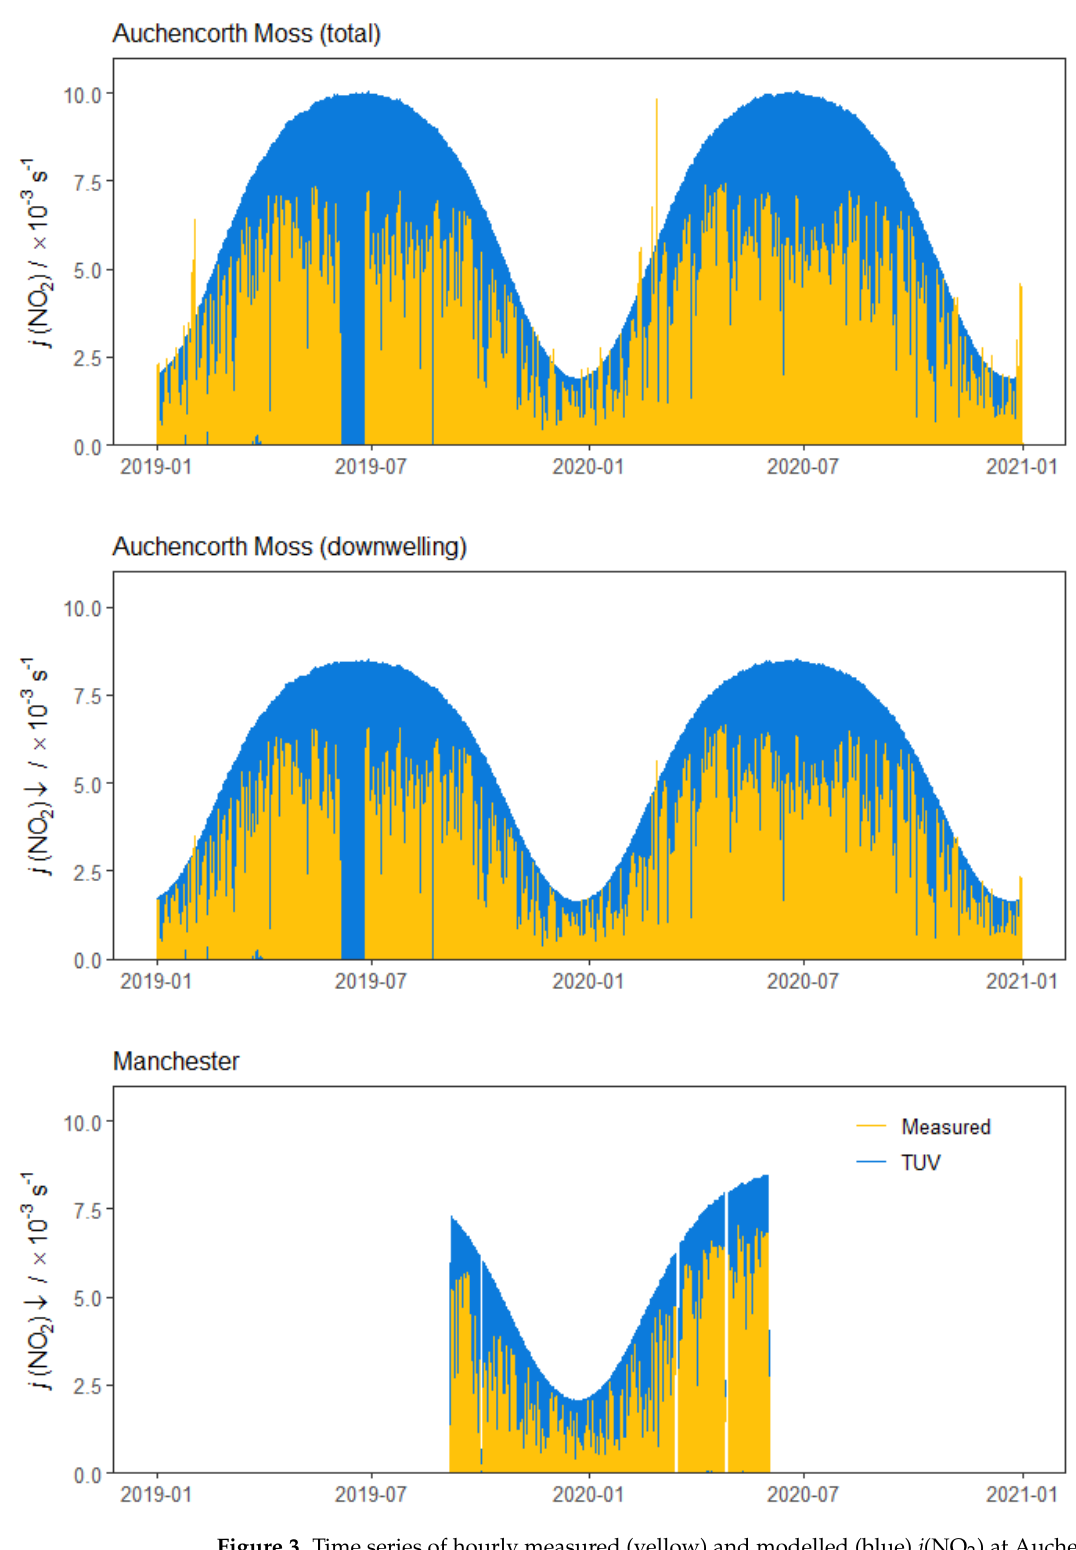
Figure 3. Time series of hourly measured (yellow) and modelled (blue) j (NO 2 ) at Auchencorth Moss and Manchester. Auchencorth data are presented for total ( ↓ + ↑ ) and downwelling-only j (NO 2 ) ( ↓ ). The missing data in June 2019 are when the filter radiometer was removed for calibration.